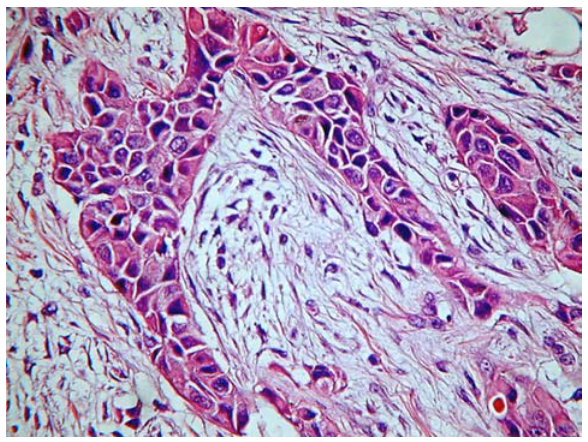
Figure 1 – Transitional cell carcinoma of the bladder with areas of squamous differentiation